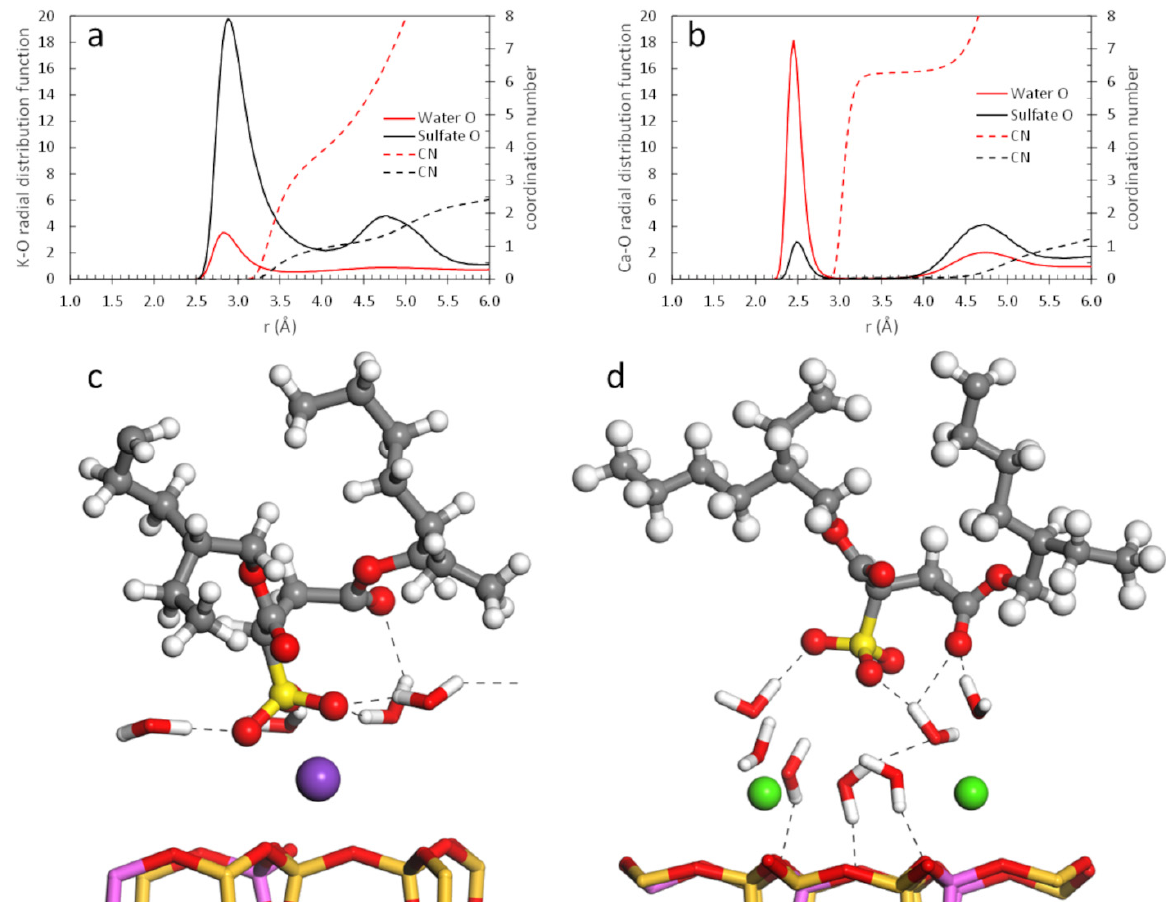
Figure 6. Results from MD simulations of 32 AOT systems at 300 K showing ( a , b ) average cation- oxygen RDFs (solid lines) and running coordination numbers (CN, dashed lines) for aqueous K + and Ca 2+ , and ( c , d ) snapshots showing representative AOT surface complexes (bottom). Atom coloring is the same as Figure 1 except that water and AOT hydrogen atoms are colored white. Hydrogen bonds are shown as black dashed lines.